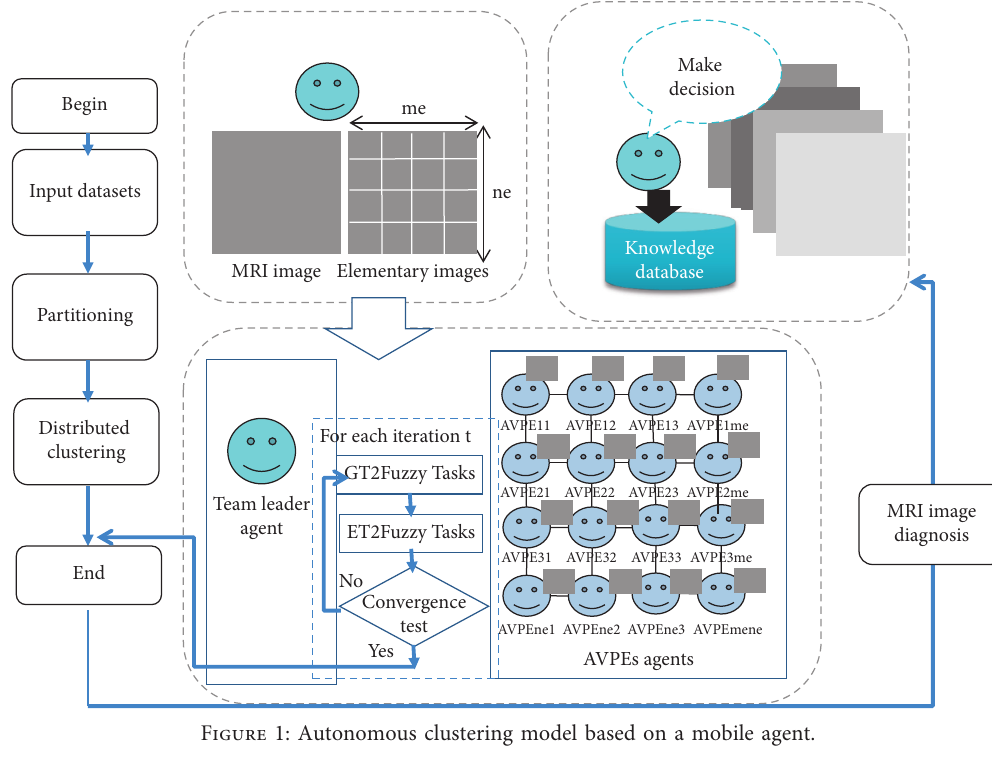
Figure 1: Autonomous clustering model based on a mobile